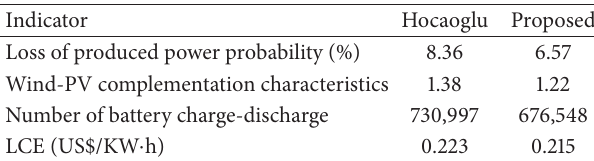
Table 6: Performance indicators.